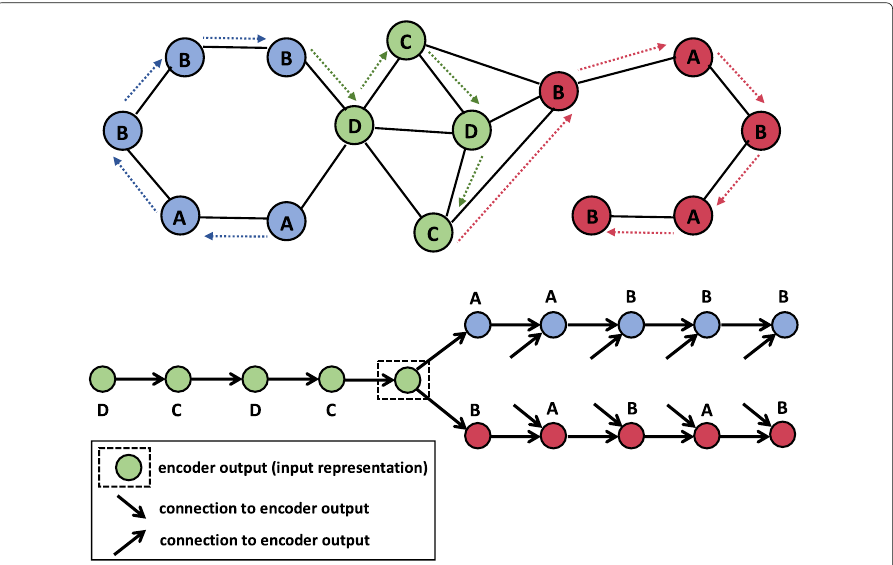
Fig. 4 A random walk over a graph can be split into three sub-sequences ( s 1 , s 2 , s 3 ) . The middle sequence is fed as input into the encoder and the decoders attempt to reconstruct the other sub-sequences. Note that the unattached arrows are connected to the encoder output to condition the decoder prediction at